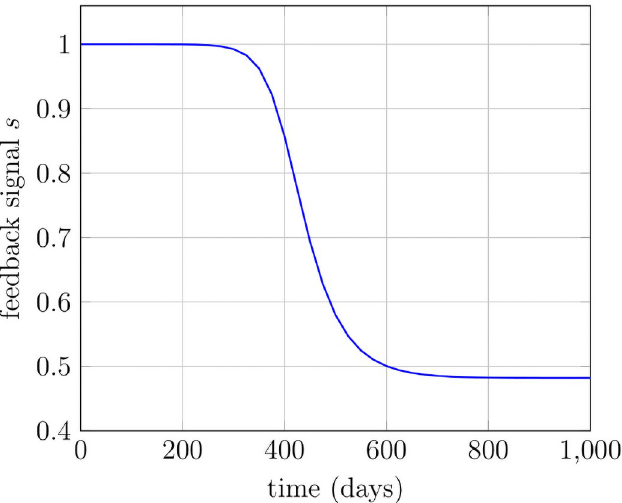
Fig 3. Cytokine feedback signals. With the increasing number of mature healthy and mutated cells, the feedback signal reduces over time.